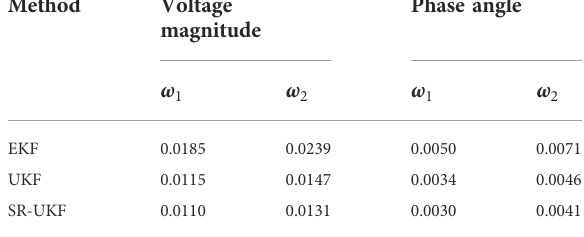
TABLE 4 Comparison bounds of node at t = 13